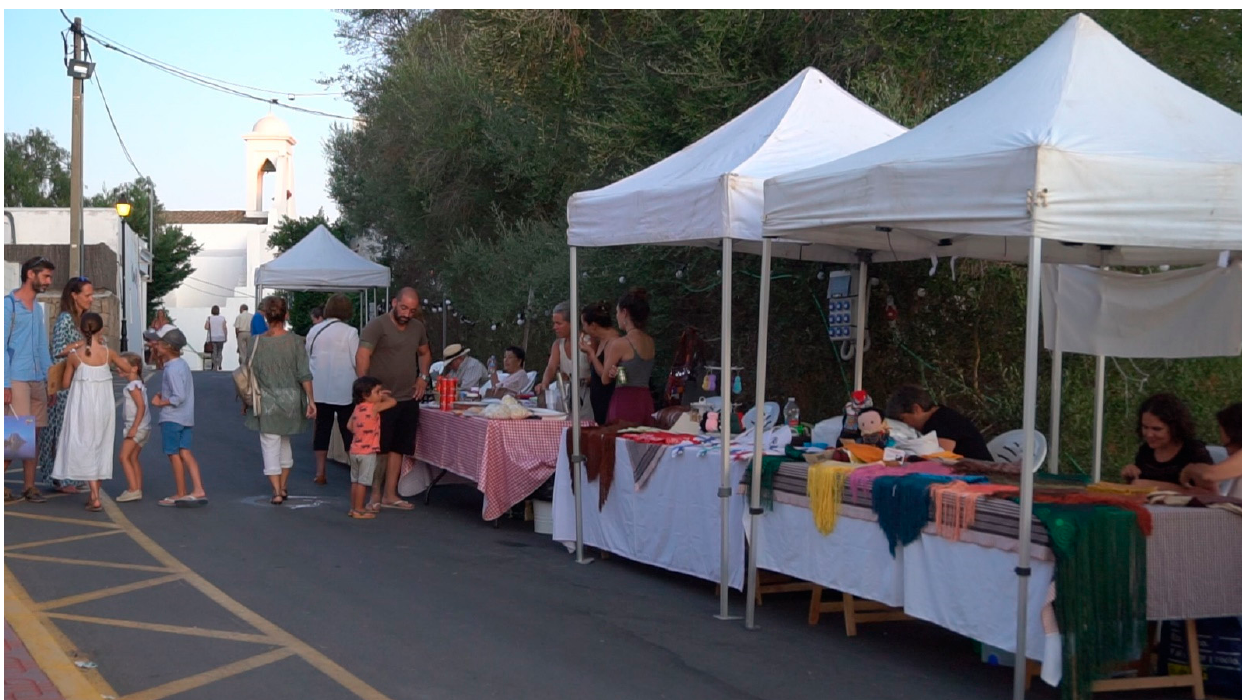
Figure 5. Sant Rafel handicraft market (authors’ own elaboration).